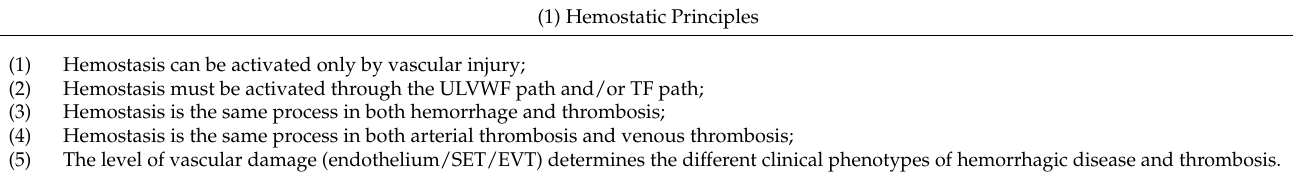
Table 2. Three fundamentals in normal